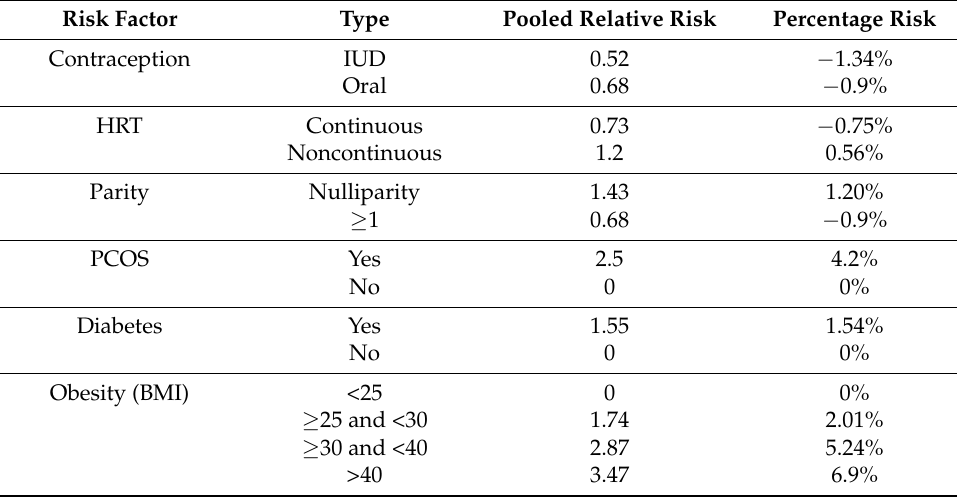
Table 2. Pooled relative risk and percentage risk for each risk